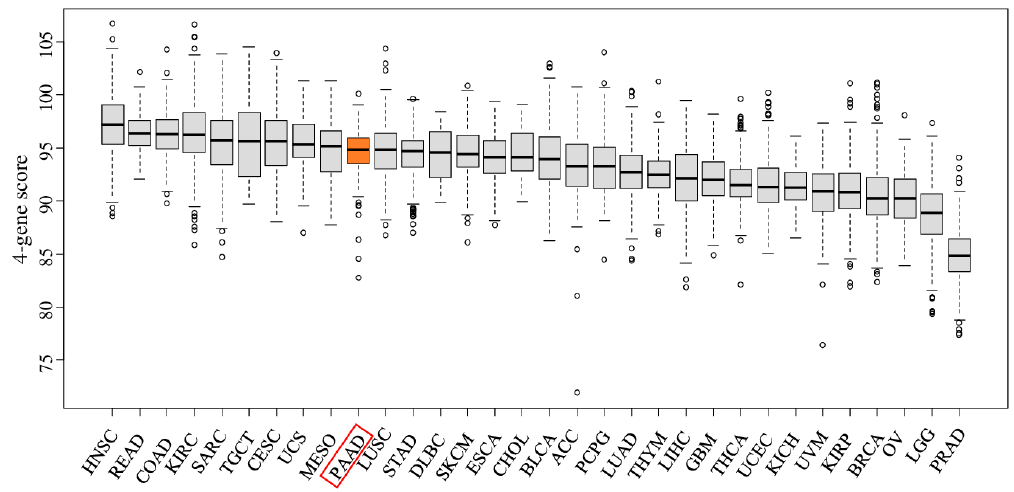
Figure 1. The four-gene score across multiple cancer types. Boxplots of the four-gene score comparing all cancer types from The Cancer Genome Atlas (TCGA) cohort. Tukey-type boxplots showed median and inter-quartile level values. ACC: adrenocortical carcinoma; BLCA: bladder urothelial carcinoma; BRCA: breast invasive carcinoma; CESC: cervical squamous cell carcinoma and endocervical